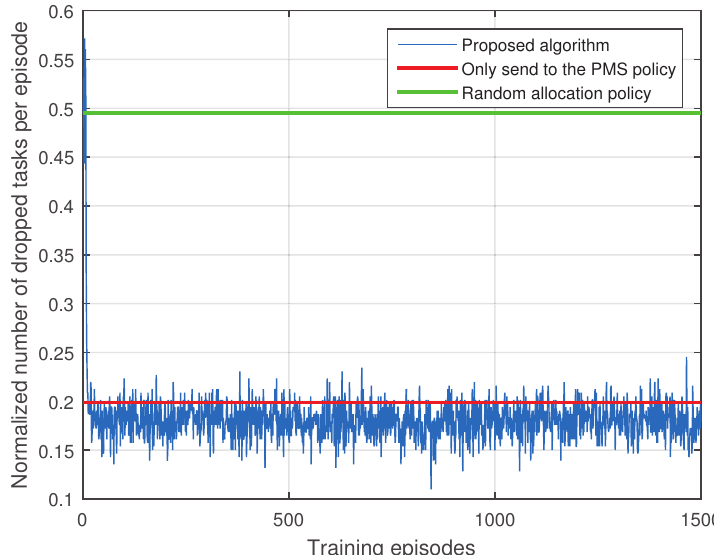
Figure 6. Comparison with benchmark polices in terms of normalized number of dropped tasks per